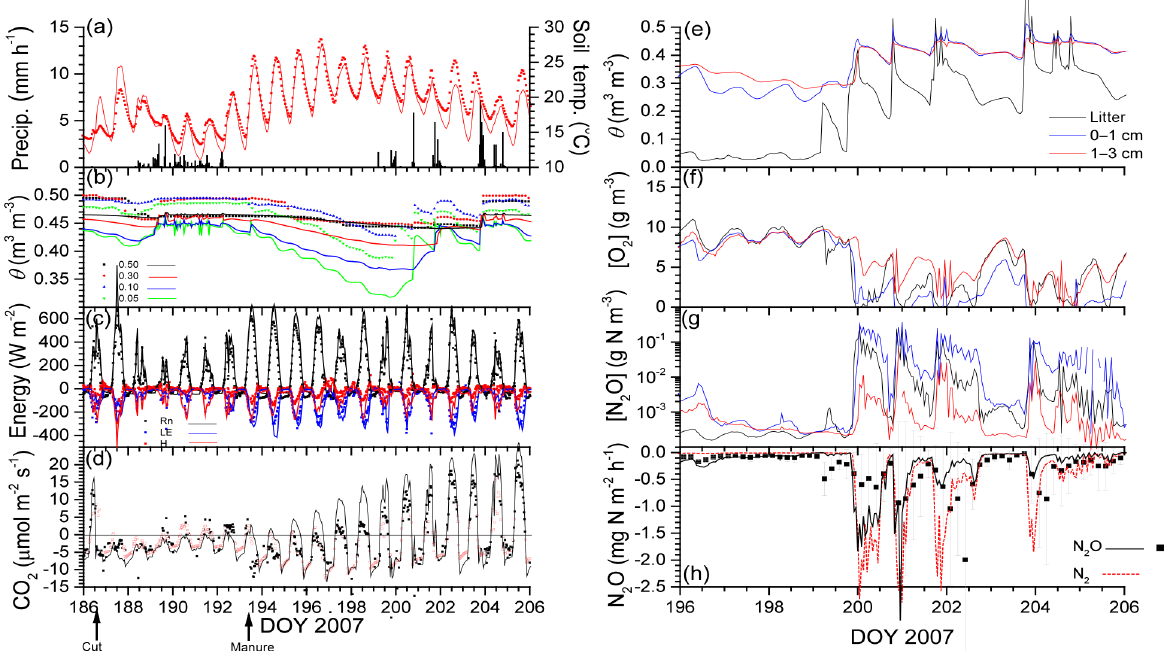
Figure 4. (a) Precipitation and soil temperature at 0.05m, (b) soil water content ( θ ) at 0.05, 0.10, 0.30 and 0.50m, (c) energy, and (d) CO 2 fluxes measured (closed symbols), gap-filled (open symbols) and modelled (lines) during 20 days from harvest (cut) to the end of the emission event following manure application (manure) in July 2007. (e) θ , (f, g) aqueous concentrations of O 2 and N 2 O modelled in the surface litter and at 0.01 and 0.02m in the soil, and (h) N 2 O and N 2 fluxes measured (symbols) and modelled (lines) during the last 10 days of this period when the emission event occurred. For fluxes, positive values represent influxes to the soil, negative values effluxes to the atmosphere. [N 2 O ( s ) ] also drove rises in modelled N 2 emissions (Fig.